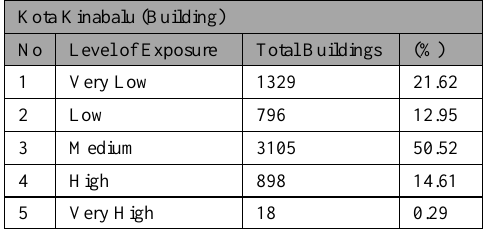
Table 1: Level of building exposure toward hazard in